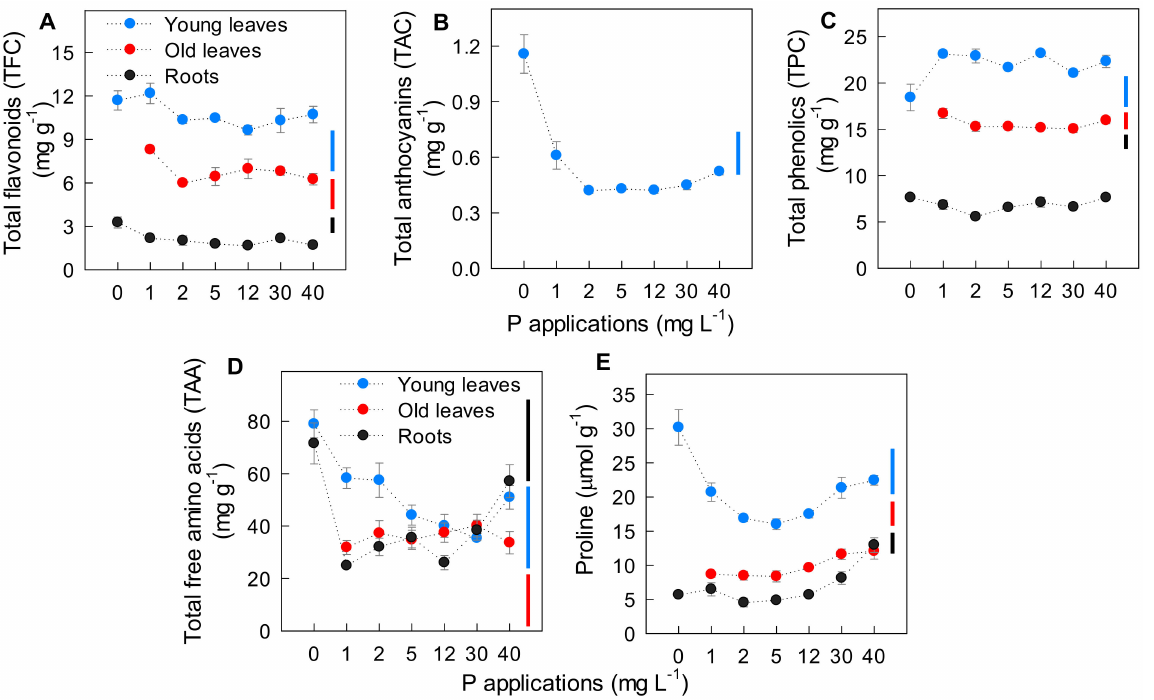
Figure 3. Effect of different P applications on the concentration of ( A – C ) secondary metabolites, ( D ) total free amino acids, and ( E ) proline in young leaves, old leaves, and roots. For all measured traits, P0 data of old leaves are missing due to insufficient sample material for analyses. Error bars indicate standard error of means ( n = 4). Vertical bars represent critical value for comparisons among P applications in each plant part by Tukey’s HSD test at p ≤